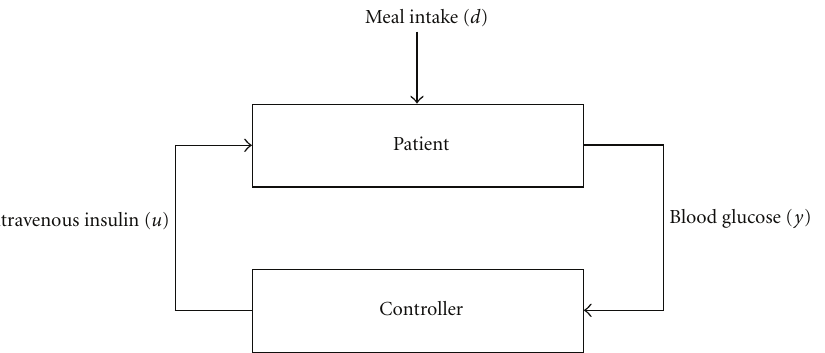
Figure 1: Diagram of the closed-loop system.